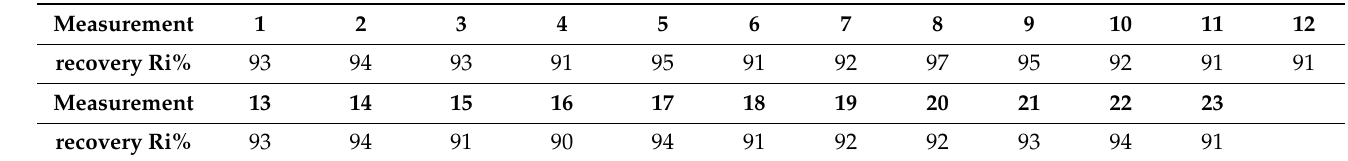
Table 9. DEHP recovery measurements in Ouzo, in the context of internal quality control of the accuracy of the